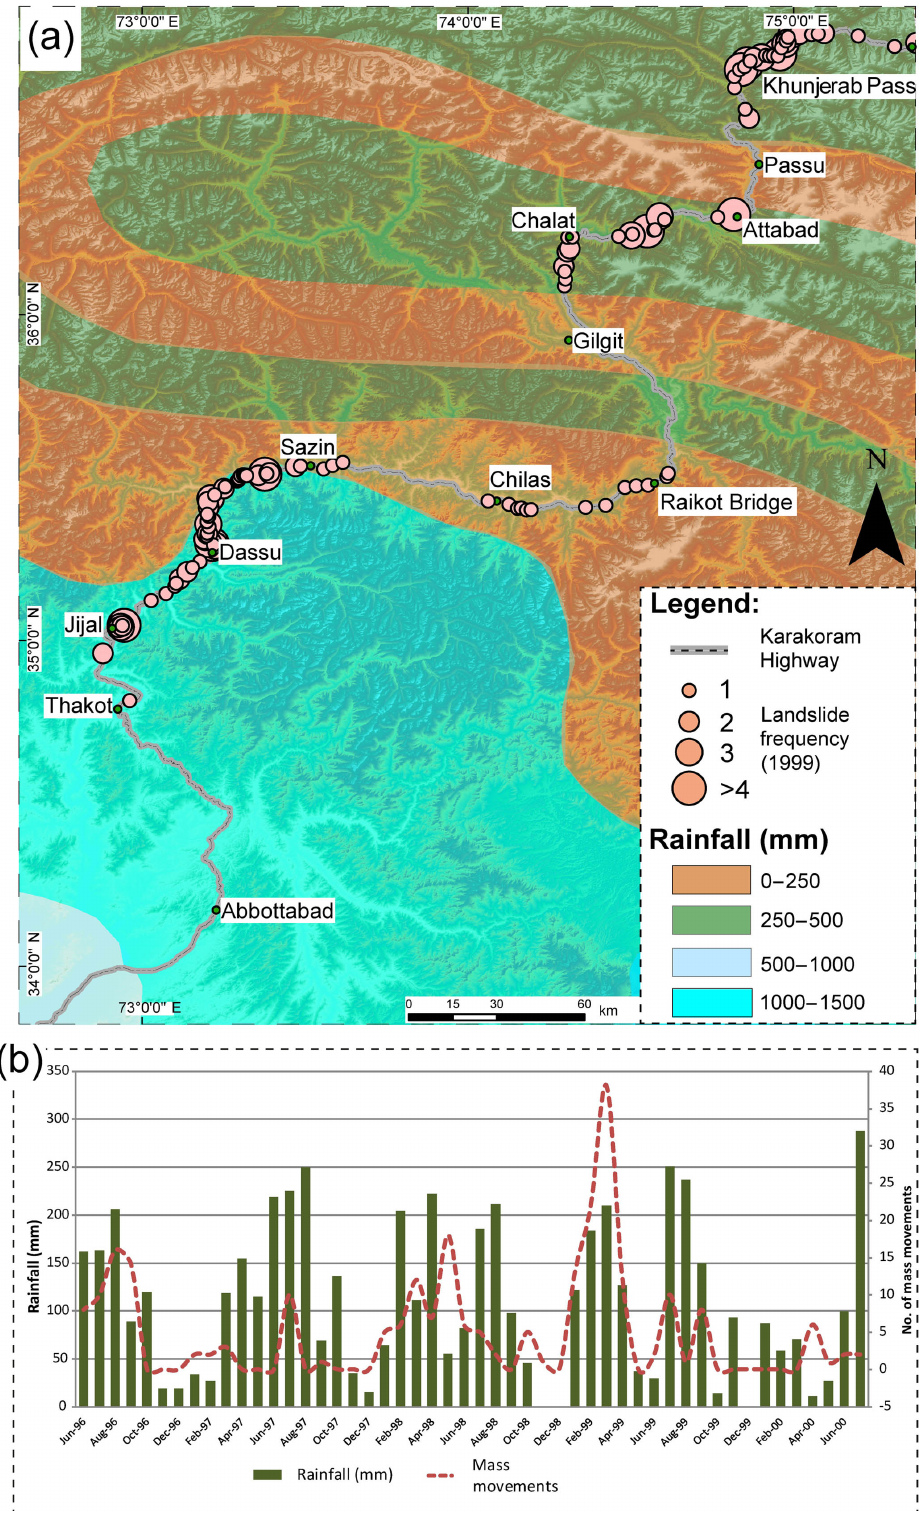
Figure 3. (a) Overview of precipitation (mean annual rainfall) and landslide frequency along the KKH (after Khan et al., 2000; Pakistan Meteorological Department 1982, 1983, 1996, 1997, 1998, 1999, 2000, 2014, 2015, 2016, Frontier Works Organization archives). (b) Cor- relation between landslide events and precipitation (Ali et al.,